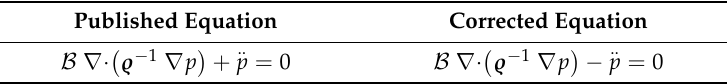
Table 1. Correct form of Equation